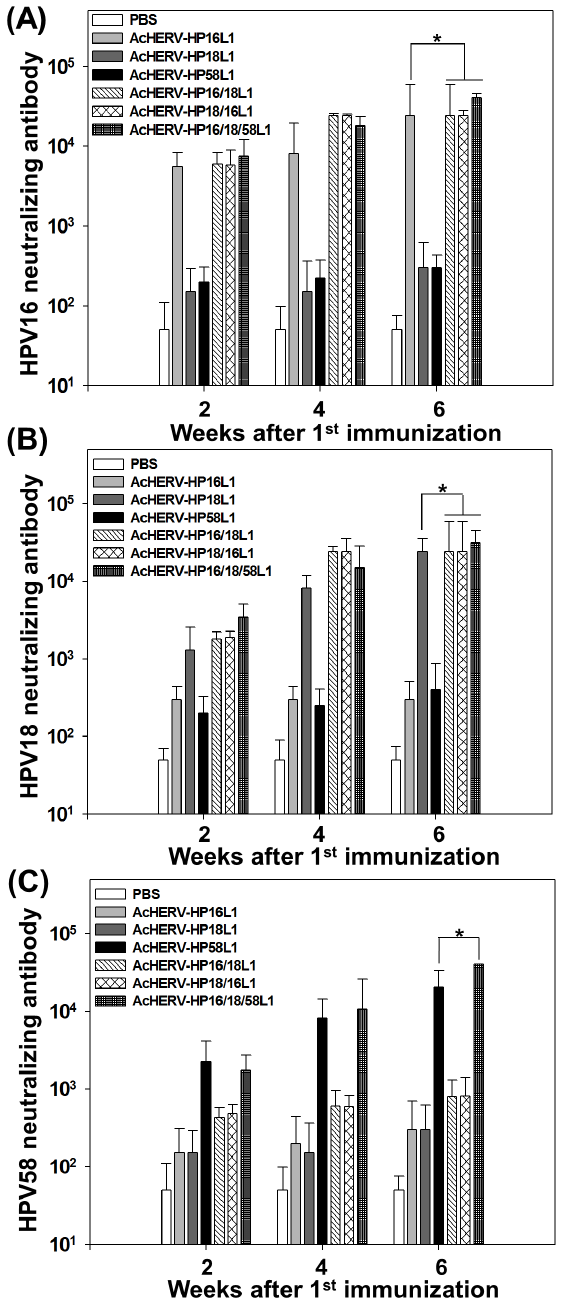
Figure 6. Induction of HPV type-specific neutralizing antibod- ies after immunization with AcHERV-based nanovaccines. Serum was sampled at 2, 4, 6 weeks after intramuscular administration with PBS or AcHERV-based nanovaccines. Neutralization assays were performed with HPV 16 (A) or HPV 18 (B) or HPV 58 (C) pseudoviruses. Data are expressed as the genometric means (log) of reciprocal serum dilutions that yielded a 50% reduction in SEAP. * p , 0.05 (ANOVA and Student-Newman-Keuls test): Bivalent and trivalent groups were compared with each monovalent group.